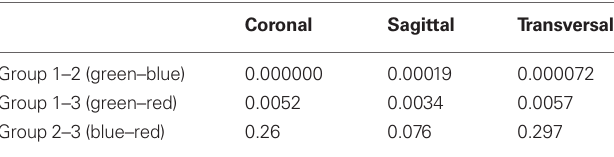
Table 4 | Significance levels for 2D K–S test applied on types of points as defined by the K-means test (data from both monkeys combined).